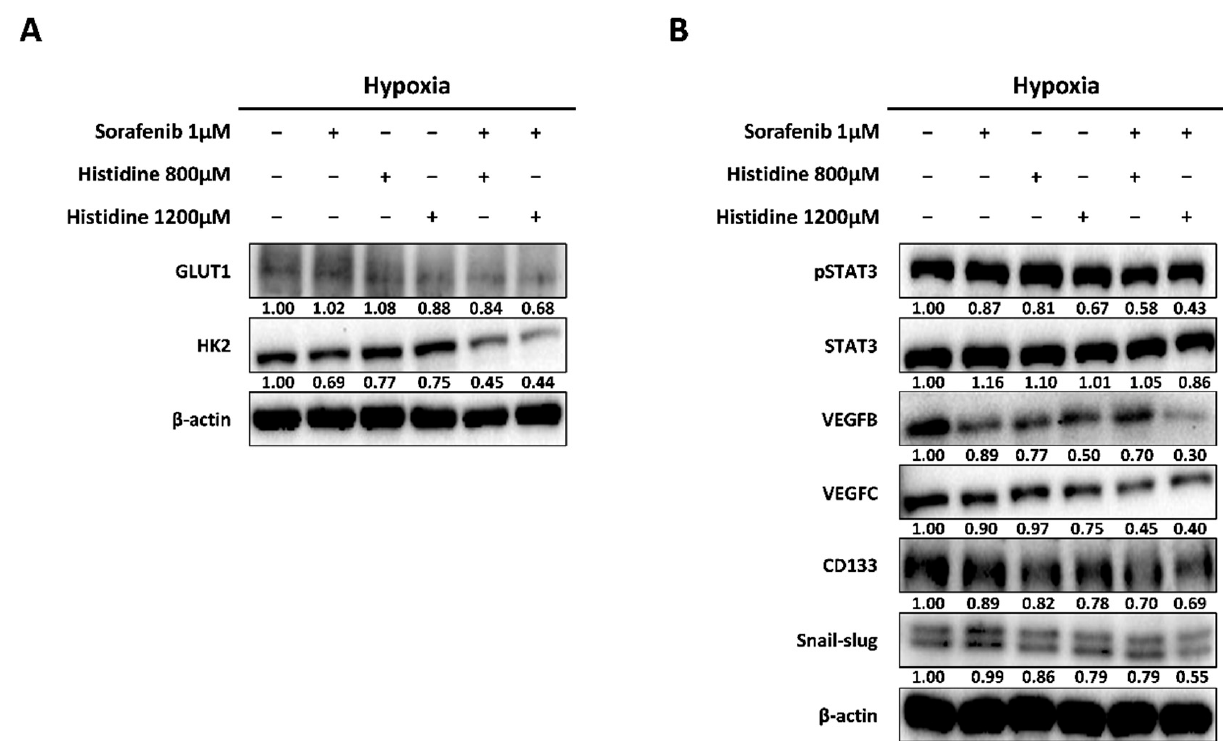
Figure 4. Anti-cancer effect of the combination of sorafenib and histidine. ( A ) HepG2 cells were treated with the combination of sorafenib and histidine at the indicated concentrations in EBSS media under hypoxia (1% oxygen). After 24 h, GLUT1, LAT1, HK2, and β -actin expression levels were determined by Western blotting. The ratios of the band intensities normalized by actin are reported below the respective panels. The presented images are cropped and the whole blot images are presented in Figure S11. Data shown represent one of three independent experiments with similar results. The quantification of band intensities from three independent experiments are shown in Figure S4A,B. ( B ) In the same conditions as used for (A), pSTAT3, STAT3, VEGF B, VEGF C, CD133, Snail/slug, and β -actin expression levels were measured by Western blotting. The ratios of the band intensities normalized by actin are reported below the respective panels. The presented images are cropped and the whole blot images are presented in Figure S12. Data shown represent one of three independent experiments with similar results. The quantification of band intensities from three independent experiments are shown in Figure S4C–G.